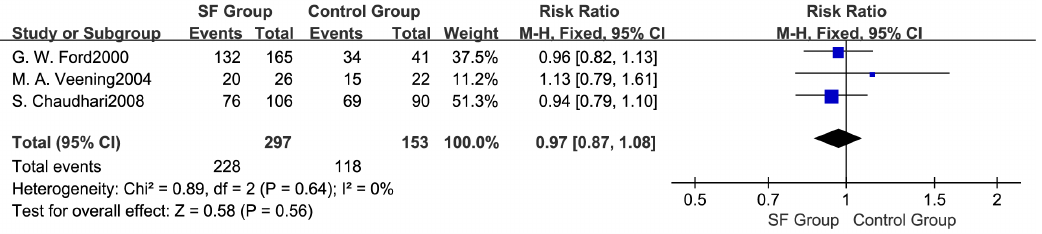
Figure 2. Forest plot for the number of pubertal children between SF group and Control group.